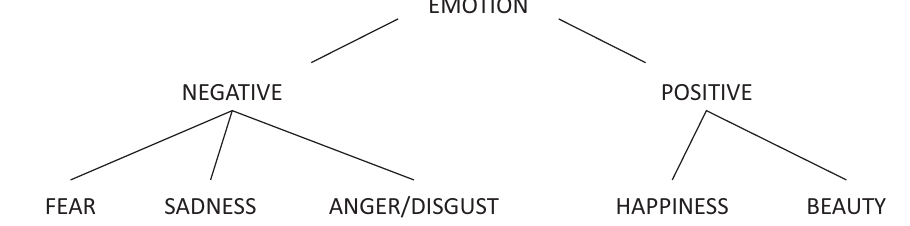
Figure 2. High level emotion ontology for the emotions used in manual and semi-automated tweet